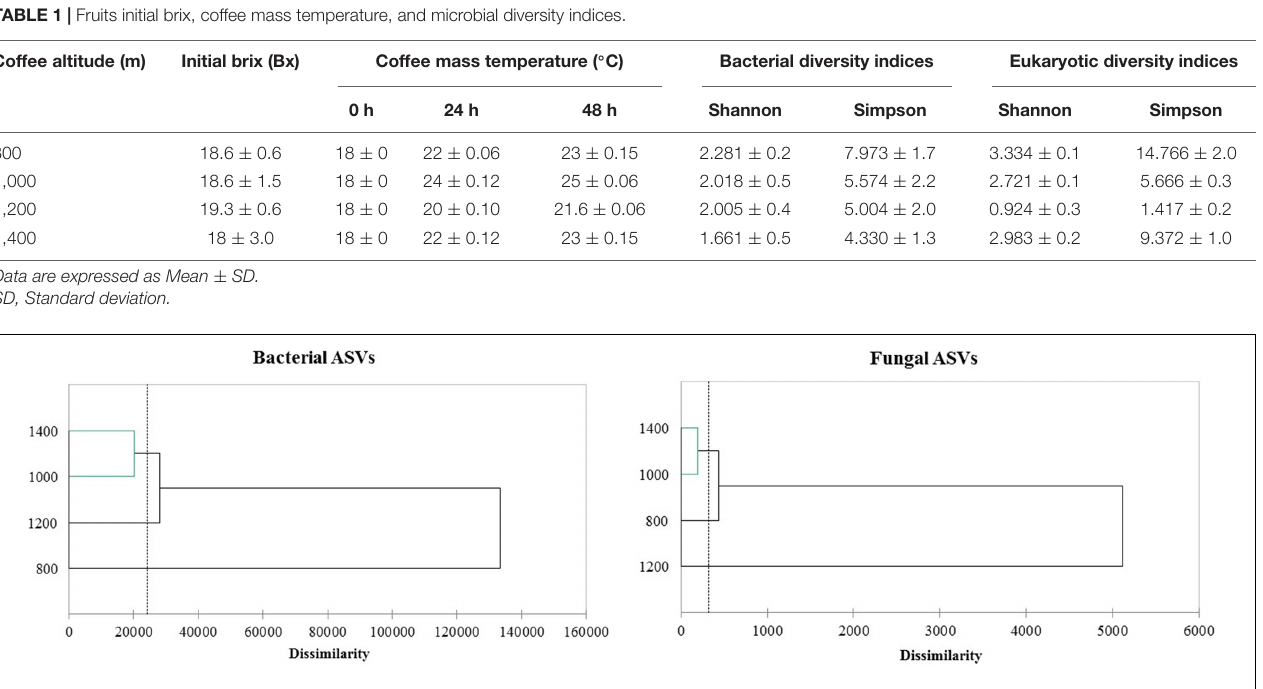
FIGURE 1 | Clustering of ASVs profile from amplicon sequence of the 16S and ITS region.